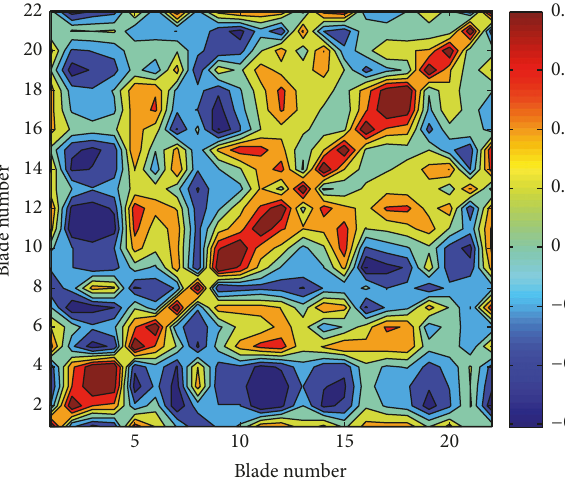
Figure 5: Correlation map for the impact